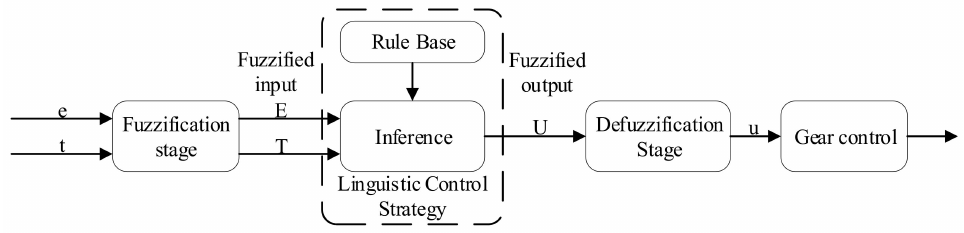
Figure 9. Fuzzy control structure.